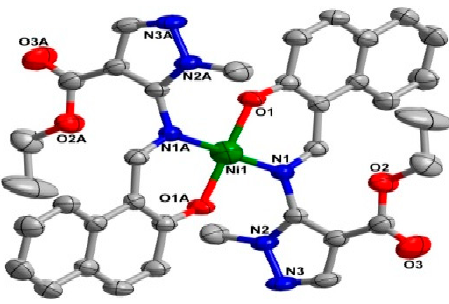
Figure 2. X-ray crystal structure of complex 2 along with atomic numbering, hydrogen atoms have been omitted for clarity. Table 1. Crystallographic data and structure refinement parameters for 1 and 2 .